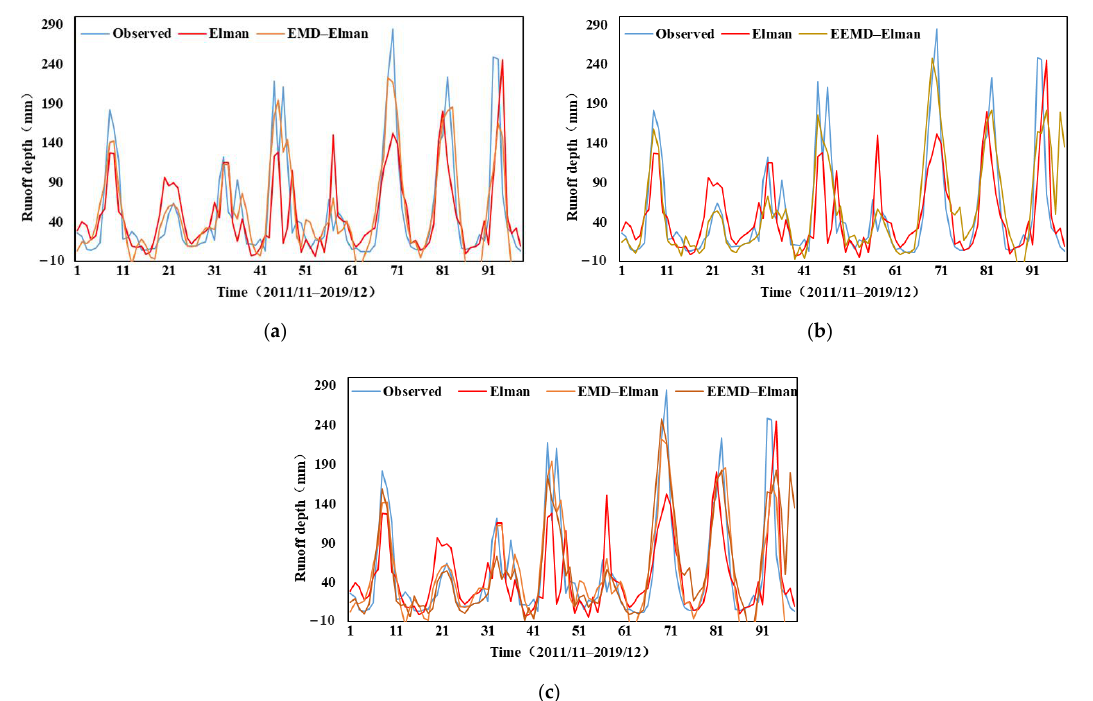
Figure 7. Forecasted and observed monthly streamflow during the validation period by the BP model, based on EMD and EEMD pre-processing techniques. ( a ) Prediction results of EMD – BP model. ( b ) Prediction results of EEMD – BP model. ( c ) Prediction results of EMD – BP model, and EEMD – BP model.